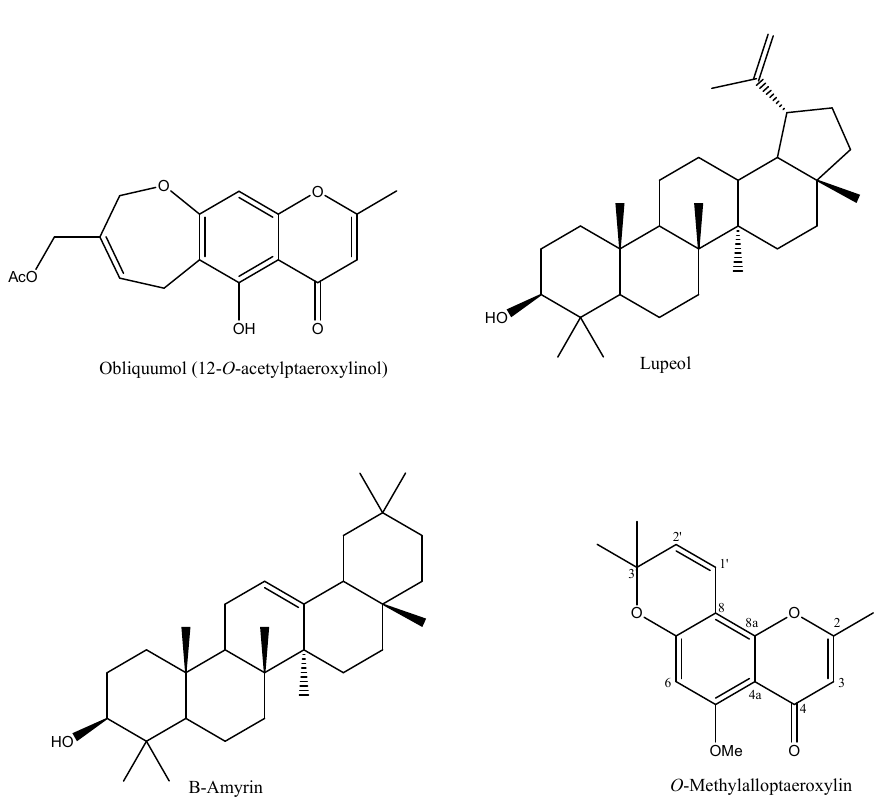
Figure A1. Structures of isolated compounds from P. obliquum leaves.